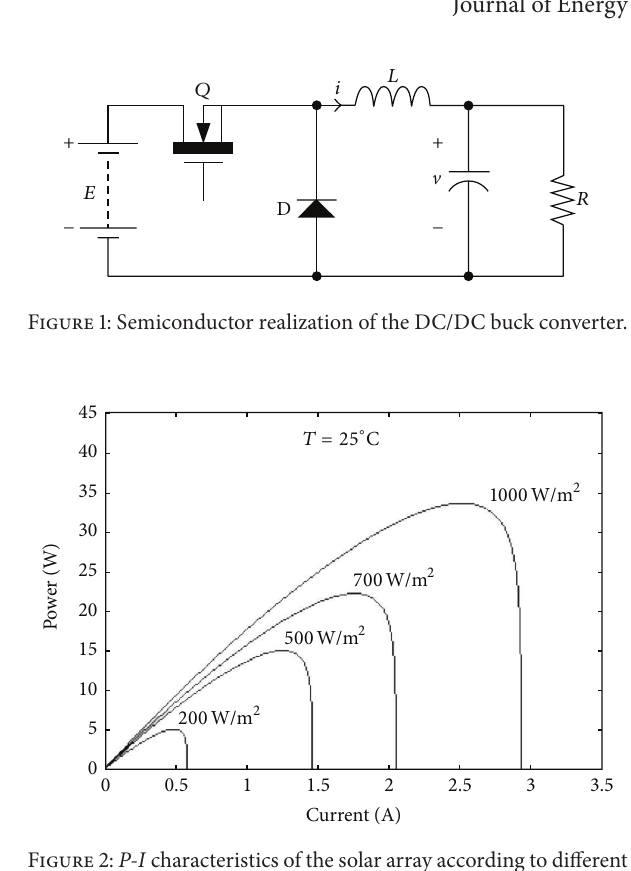
Figure 2: P-I characteristics of the solar array according to different insolation (for 𝑇 = 25 ∘